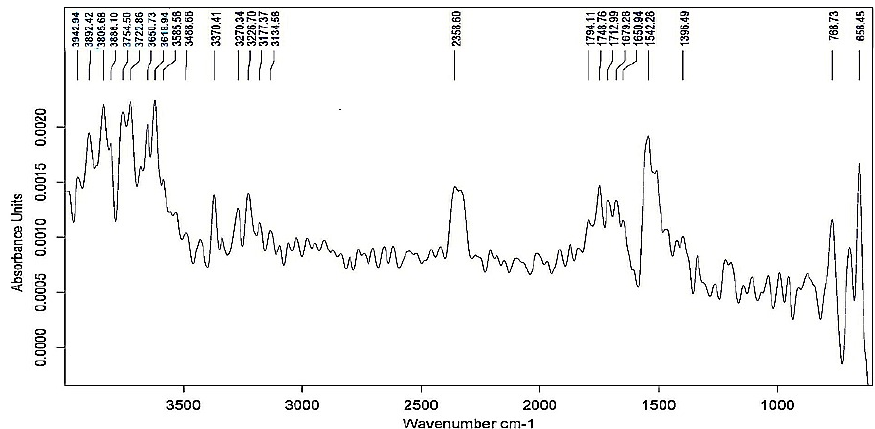
Figure 1. FTIR spectrum of the functional groups present in purified biosurfactant produced from BSP9.